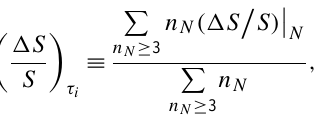
Fig. 5. (cid:0) 1S (cid:14) S (cid:1) at τ 4 (40ms), τ 5 (80ms), and τ 6 (160ms) for the τ i determination of the upper limit of Regime 1.